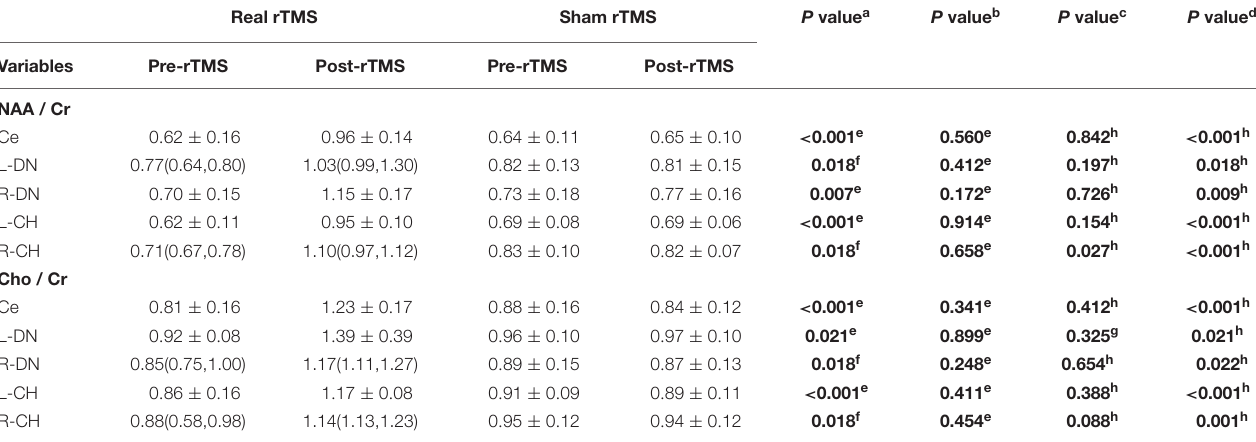
TABLE 3 | The NAA/Cr and Cho/Cr values in the real and sham interventions before and after stimulation. Real rTMS Sham rTMS